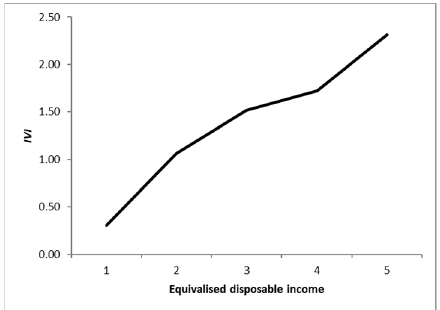
Figure 5. Mean energy consumption per household by group of cities.